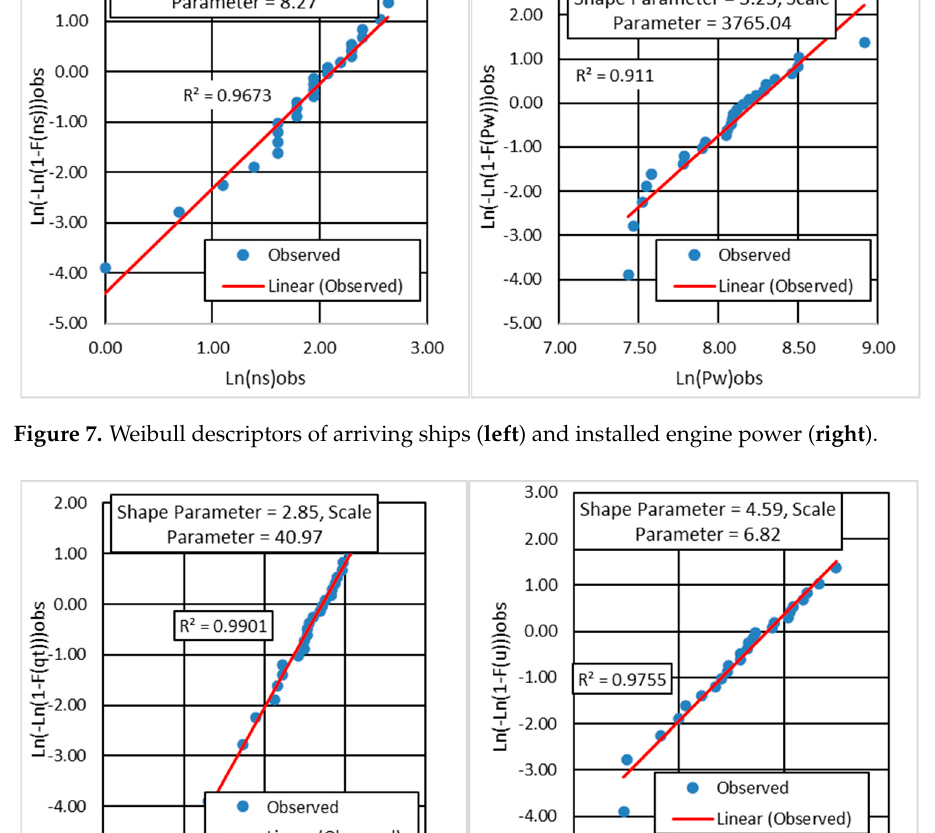
Figure 6. Average wind direction ( left ) and weather stability ( right ).